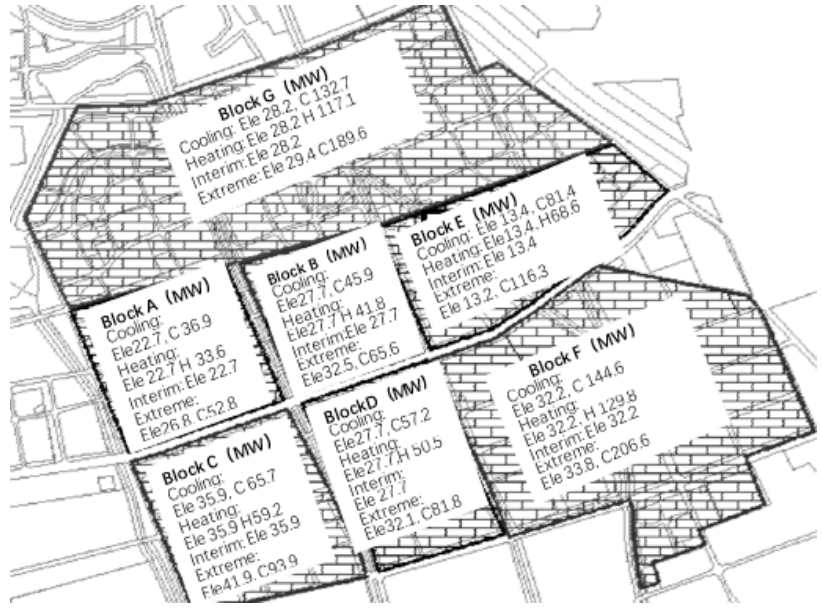
Figure 6. Map showing the energy supply planning information of the case study area.